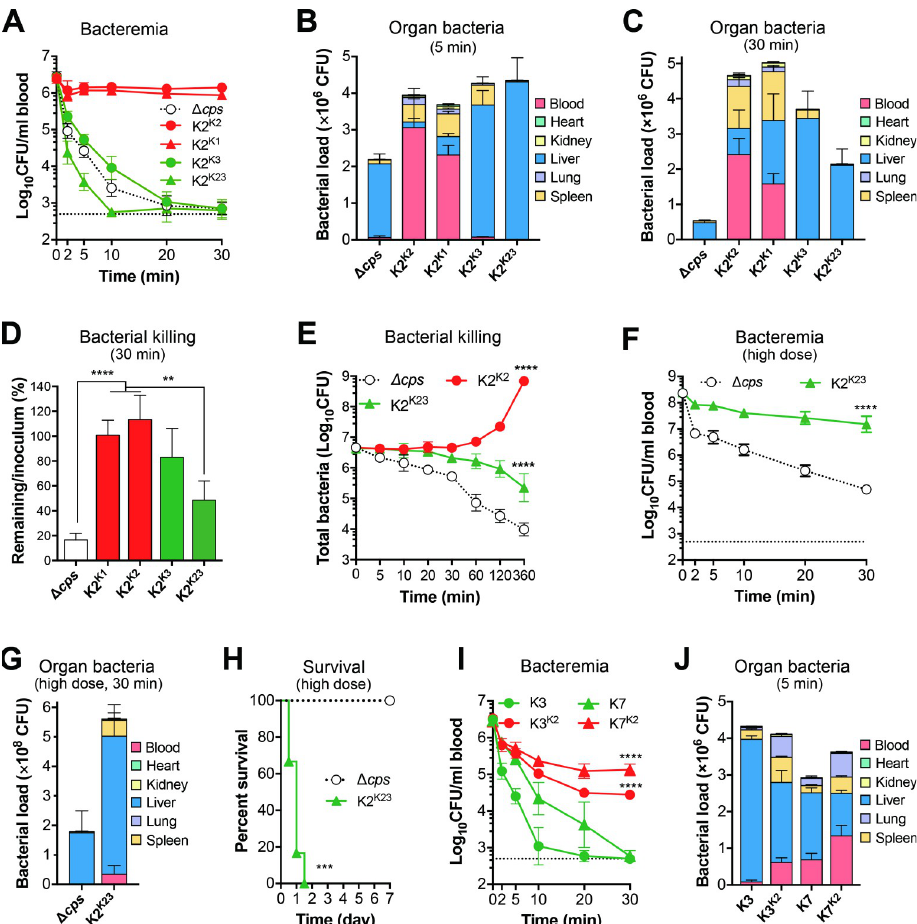
Fig 3. Capsule type-dependent capture of circulating K . pneumoniae in the liver. A - D. Superior protection of HV capsule types against hepatic clearance of K . pneumoniae in the early phase of septic infection. ATCC43816 (K2) derivatives in the first 30 min of septic infection. CD1 mice were intravenously (i.v.) infected with 5 × 10 6 CFU of isogenic acapsular mutant ( Δ cps ), and capsule switched HV (K2 K1 and K2 K2 ) or LV (K2 K3 and K2 K23 ) derivatives. CFU counts in the blood at various time points ( A ) and the major organs at 5 min ( B ) and 30 min ( C ), were determined; bacterial killing in the first 30 min was estimated by comparing the combined CFU detected in the blood and five organs with the corresponding inoculum ( D ). n = 6. E. The impact of the capsule and capsule types on bacterial survival/killing in the first 6 hr of septic infection. CD1 mice were infected with the capsular mutant ( Δ cps ), capsule switched HV derivative (K2 K2 ) or LV derivative (K2 K23 ) as in (A); the CFU counts obtained from the blood and five organs of each mouse are combined and presented as a single value at each time point. n = 6. F-H. The contribution of LV capsule type to bacterial survival. CD1 mice were i.v. infected with 5 × 10 8 CFU of acapsular ( Δ cps ) or LV (K2 K23 ) derivative of ATCC43816; CFU counts obtained with the blood ( F ) and major organs ( G ) samples; mouse survival observed for 7 days post infection ( H ). n = 6. I, J. K2 capsule-mediated protection of K3 and K7 strains against hepatic capture. LV strains K3 (TH12849) and K7 (TH12880) were compared with their progenitors K2 capsule-switched derivatives (K3 K2 and K7 K2 ) in CFU counts in the blood ( I ) and major organs ( J ) as in (A) and (B), respectively. n = 4. The data were pooled from two independent experiments in CD1 mice and presented as mean ± SD, except for data of (H), which were from one experiment. One-way ANOVA with Tukey’s multiple comparisons test (D), two-way ANOVA with Tukey’s multiple comparisons test (E, F and I) and log-rank test (H) were performed. �� , P < 0.01; ��� , P < 0.001; ���� , P <